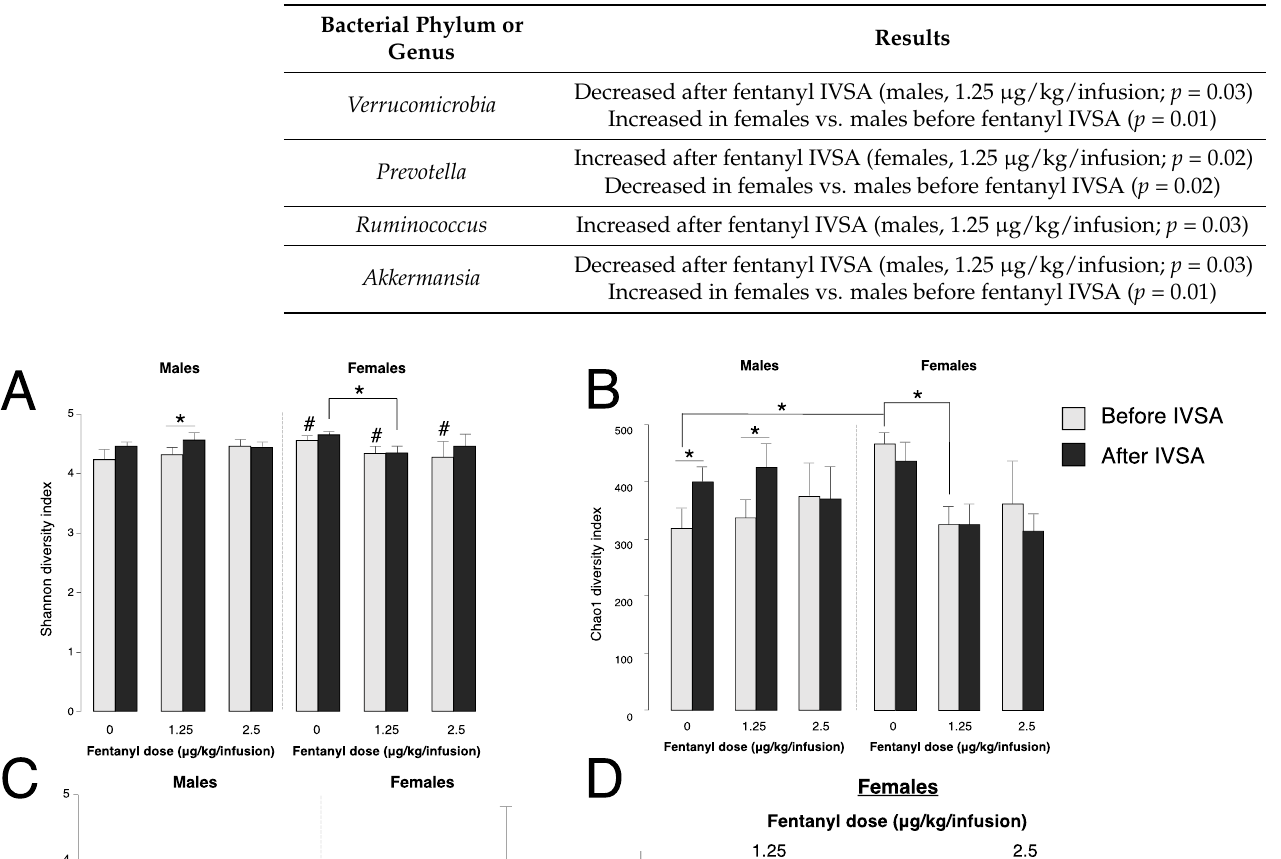
Table 2. Bacterial groups impacted by fentanyl intravenous self-administration (IVSA).